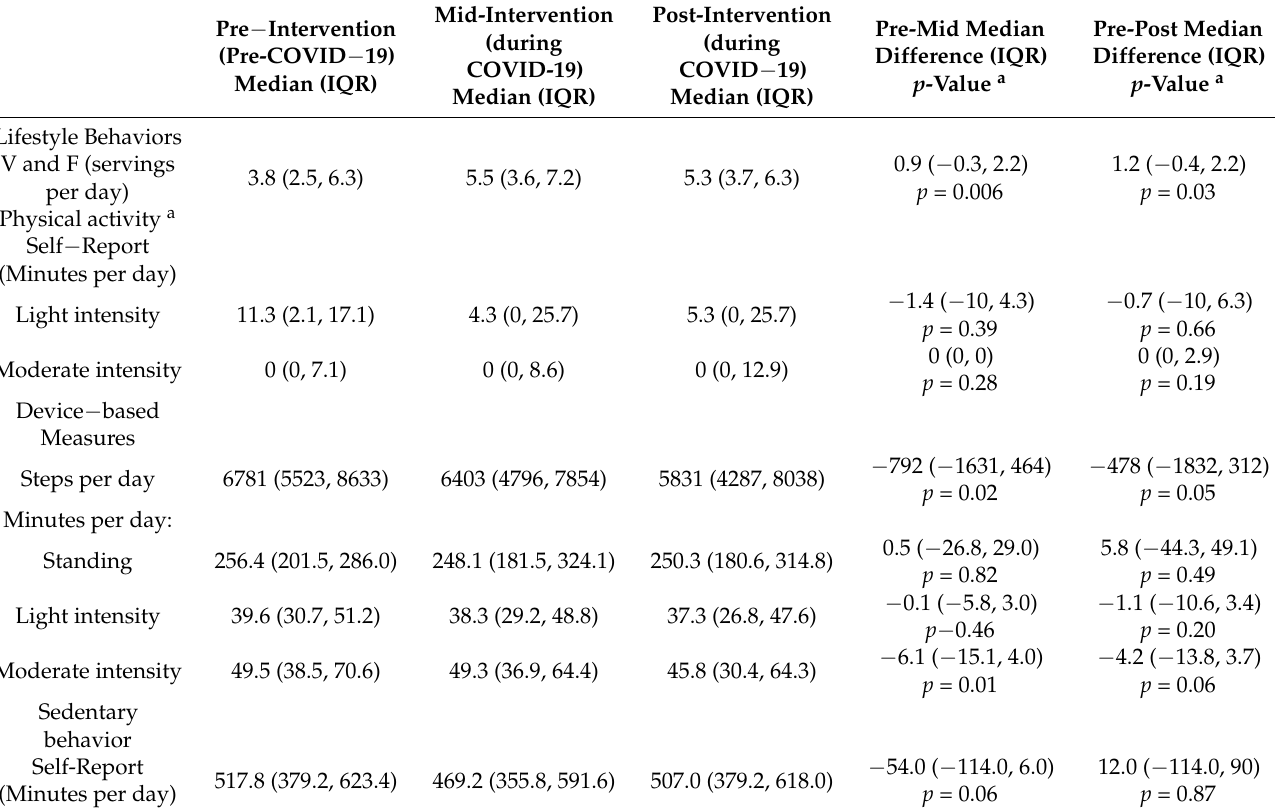
Table 2. Change in health-related outcomes during the mentored gardening